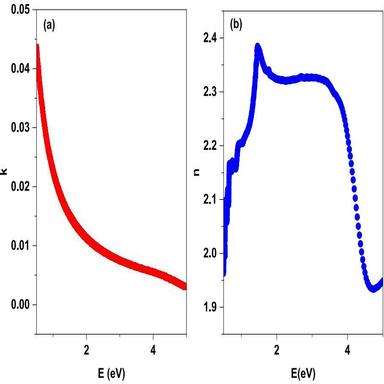
(a) Photon energy dependence of k, and (b) Photon energy dependence of n of PVA structure.